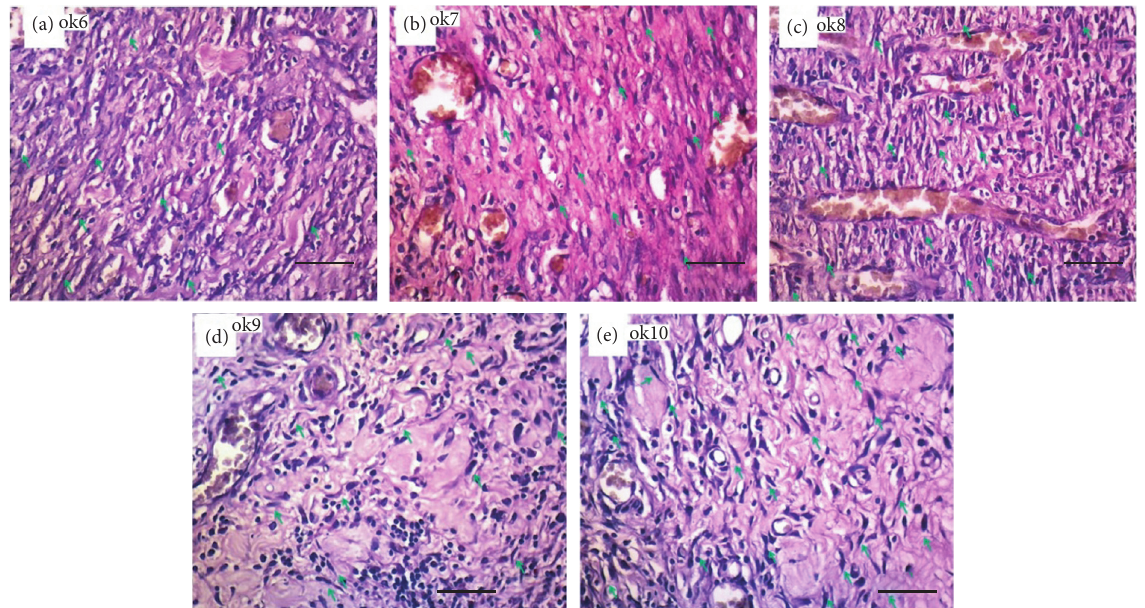
Figure 2: The number of fibroblasts on day 7. (a) Control group with nonozonated Aloe vera oil. (b) Control group with gentamicin application. (c) Treatment group with 600mg ozonated Aloe vera oil. (d) Treatment group with 1,200mg ozonated Aloe vera oil. (e) Treatment group with 1,800mg ozonated Aloe vera oil. Scale bar 50 μ